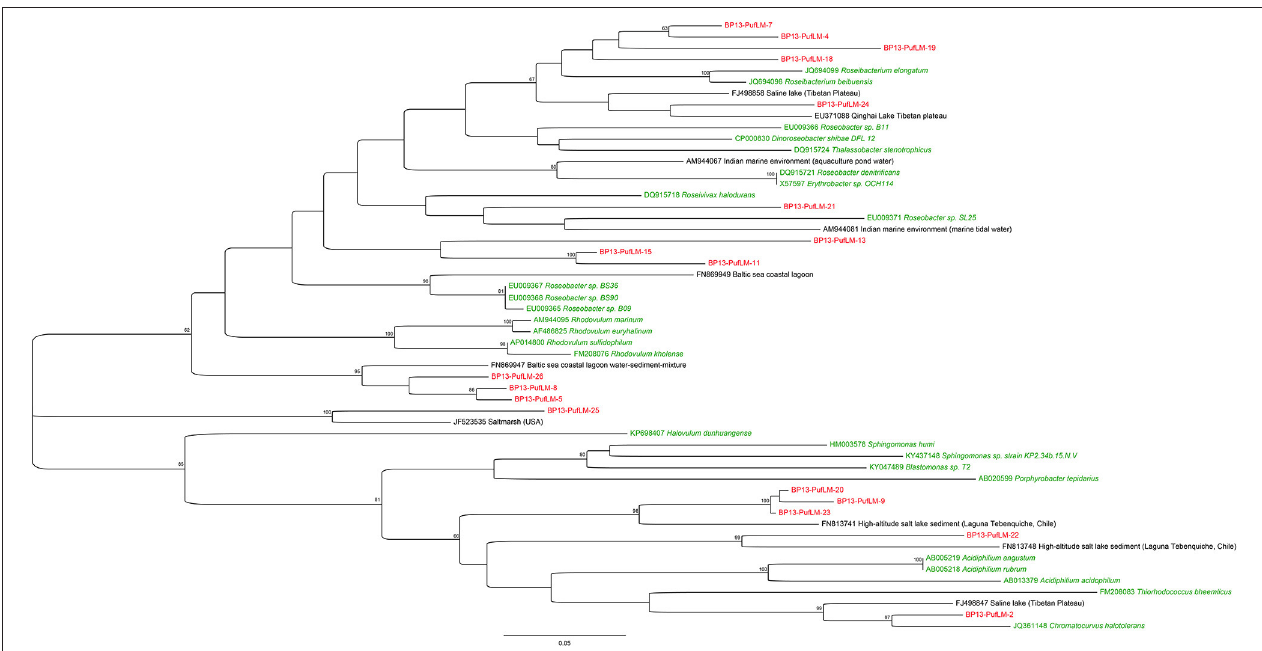
FIGURE 5 | Maximum Likelihood phylogenetic analysis of partial pufLM operons detected in the black pustular mat collected in 2013. The evolutionary history of the retrieved partial pufLM operons and of the partial pufLM operons of the closest uncultivated (black) and cultivated (green) relatives was inferred by using the Jukes-Cantor model (Jukes and Cantor, 1969). The tree with the highest log likelihood ( − 6611.4021) is shown. The percentage of trees in which the associated taxa clustered together is shown next to the branches. The tree is drawn to scale, with branch lengths measured in the number of substitutions per site. Evolutionary analyses were conducted using MEGA7 ( Tamura et al.,